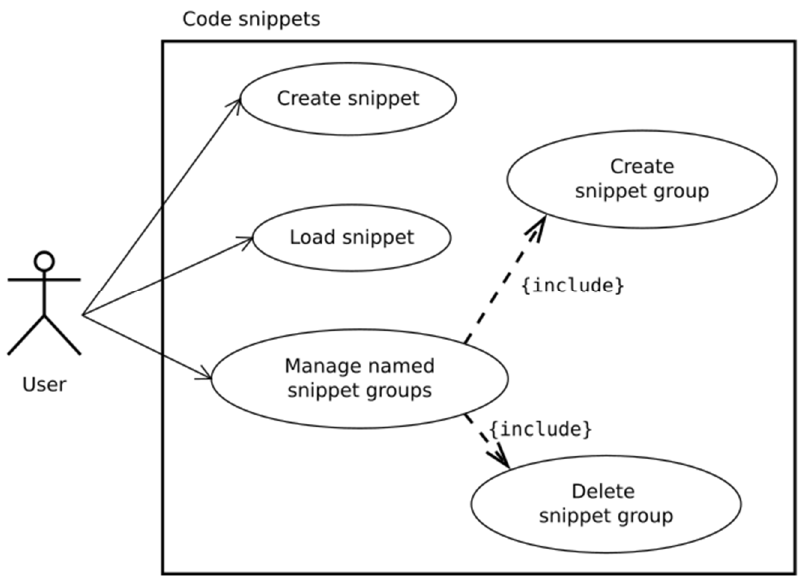
Figure 11. Code snippets use case diagram.